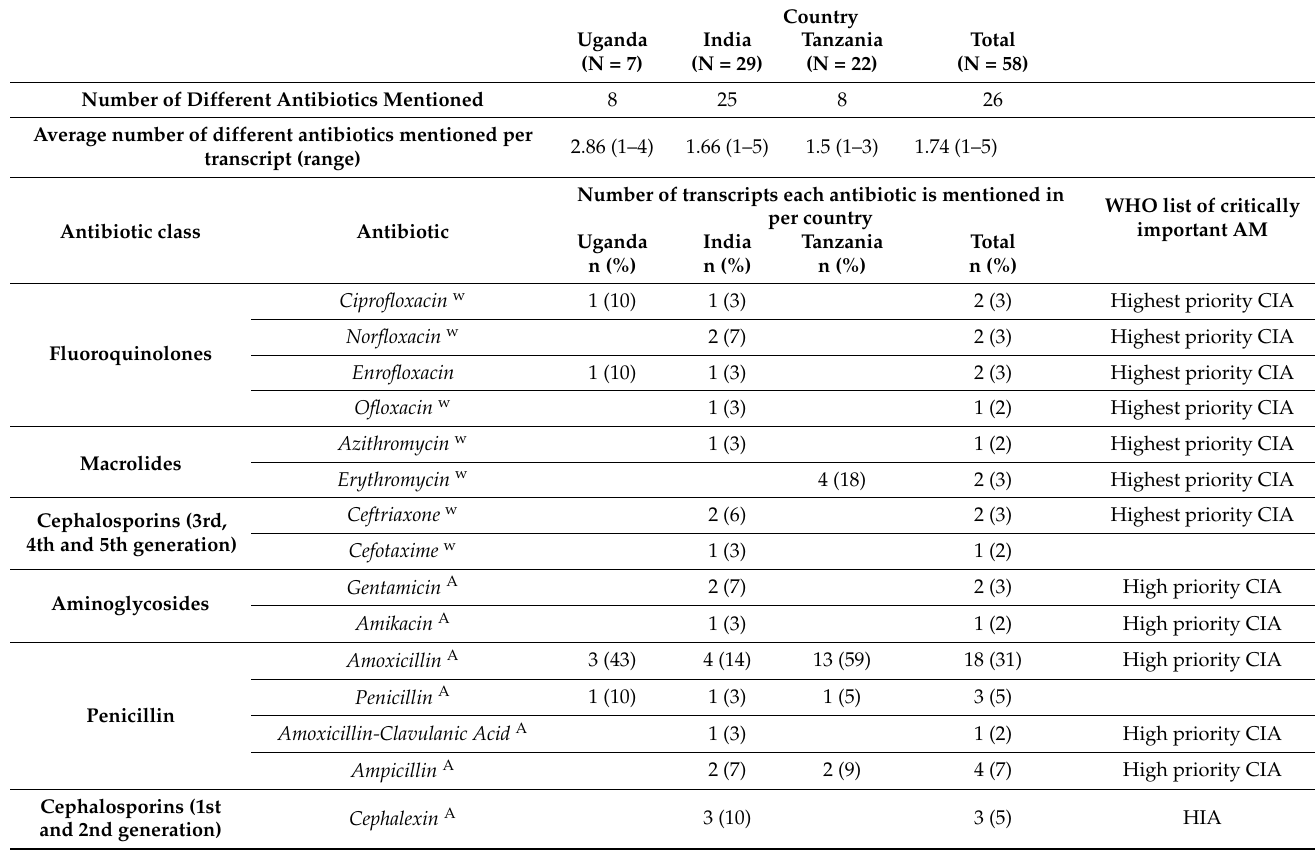
Table 4. Human antibiotic formulations per class and agent reported as used in animals by country and their importance to human